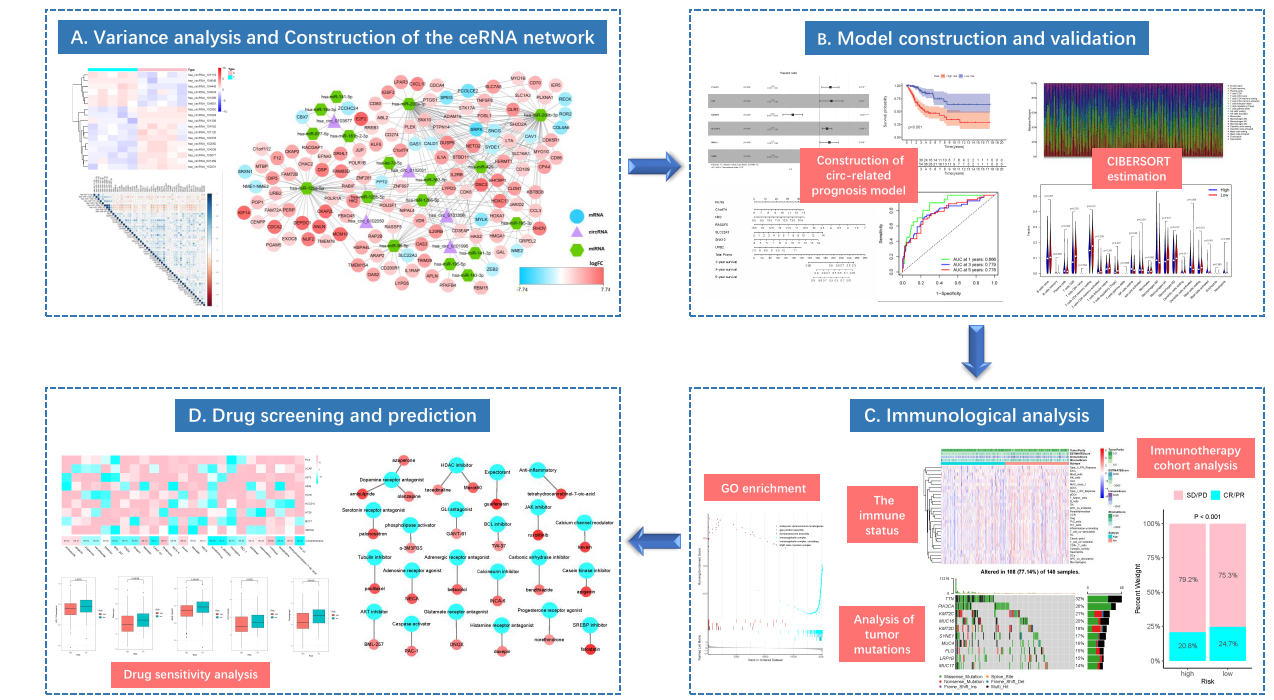
Figure 1. The flow diagram of this study (* p < 0.05; ** p < 0.01; *** p <